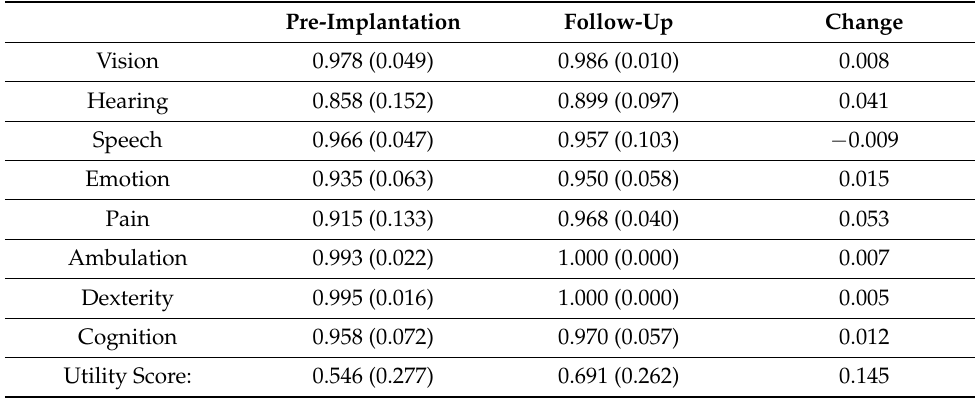
Table 2. Mean (SD) HUI-3 attribute scores, utility score, and change in score for patients with COM, with or without cholesteatoma, at pre-implantation and at 12-month follow-up ( n = 10). Pre-Implantation Follow-Up Change Vision 0.978 (0.049) 0.986 (0.010) 0.008 Hearing 0.858 (0.152) 0.899 (0.097) 0.041 Speech 0.966 (0.047) 0.957 (0.103) − 0.009 Emotion 0.935 (0.063) 0.950 (0.058) 0.015 Pain 0.915 (0.133) 0.968 (0.040) 0.053 Ambulation 0.993 (0.022) 1.000 (0.000) 0.007 Dexterity 0.995 (0.016) 1.000 (0.000) 0.005 Cognition 0.958 (0.072) 0.970 (0.057) 0.012 Utility Score: 0.546 (0.277) 0.691 (0.262)